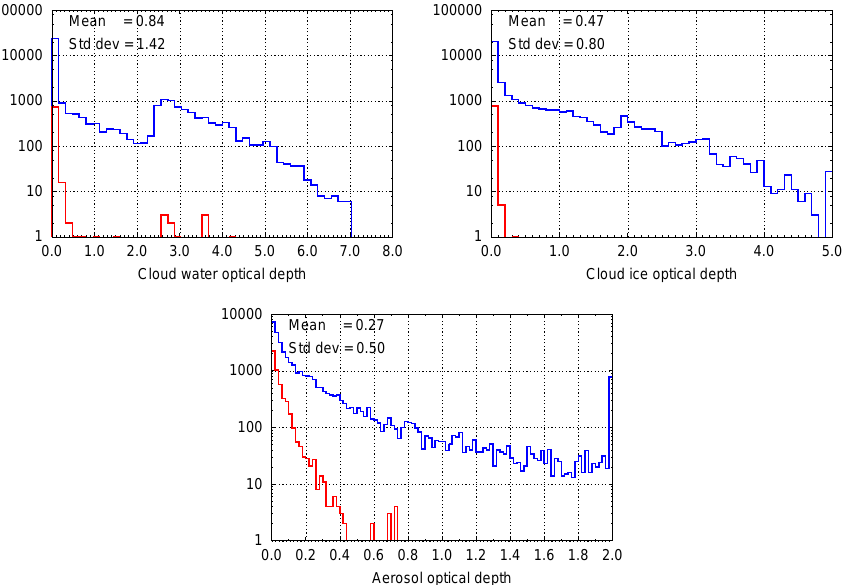
Figure 8. Histograms of the optical depth of cloud liquid water, cloud ice and aerosol for the ensemble of soundings in the simulation. The histograms in blue refer to the whole ensemble; those in red apply after the post-processing filter.